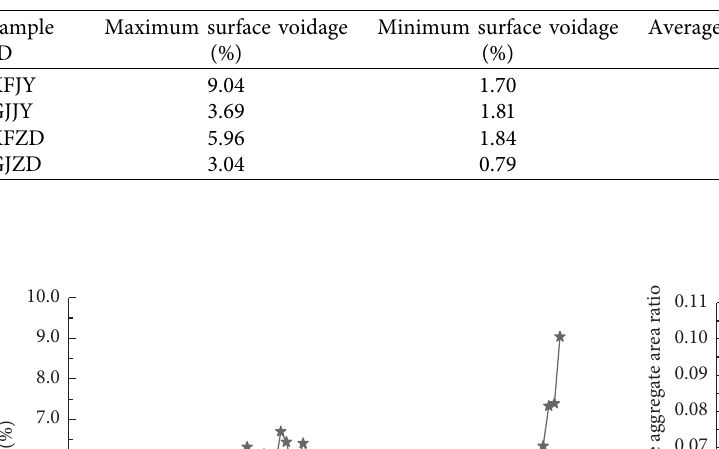
Table 3: Statistical results of the surface voidage distribution.